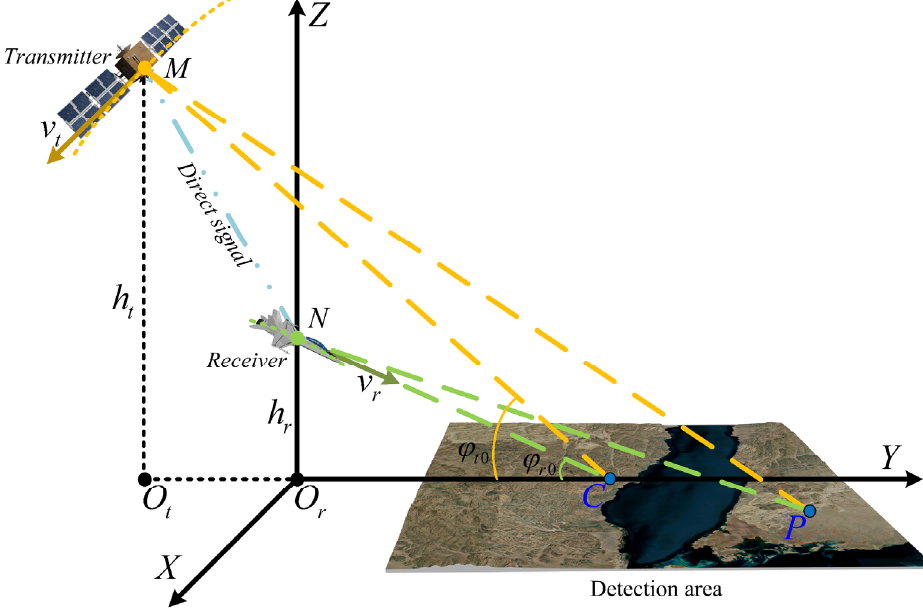
Figure 1. Spaceborne HS-BFSAR imaging geometry.